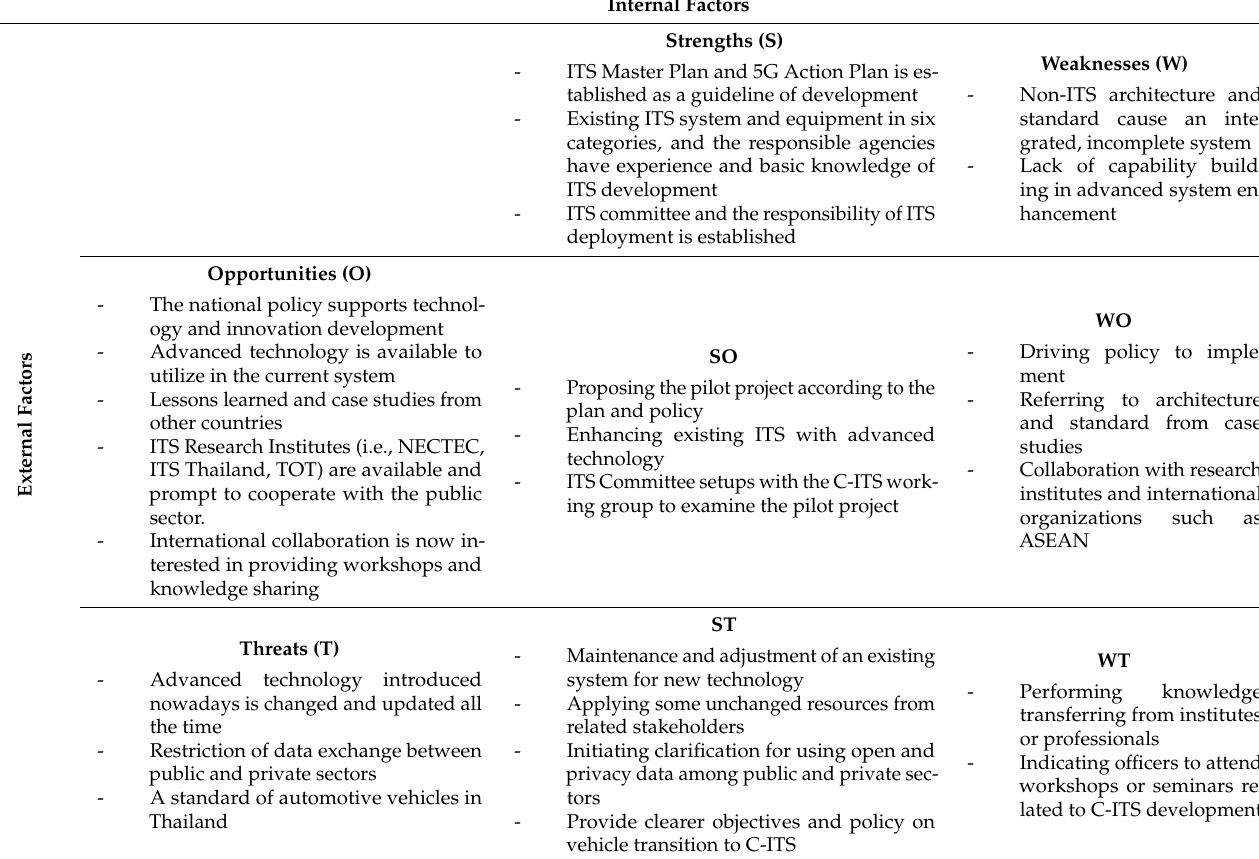
Table 3. Result of SWOT (Strength, Weakness, Opportunity, Threat) and TOWS (Threat, Opportunity, Weakness, Strength) analysis for C-ITS development in